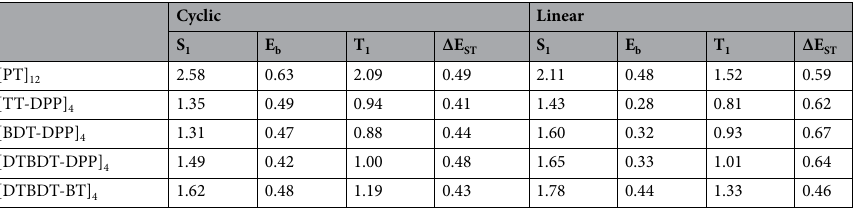
Table 4. Calculated lowest singlet (S 1 ), triplet (T 1 ) excitation energies, Singlet–triplet gap ΔE ST and exciton binding energy E